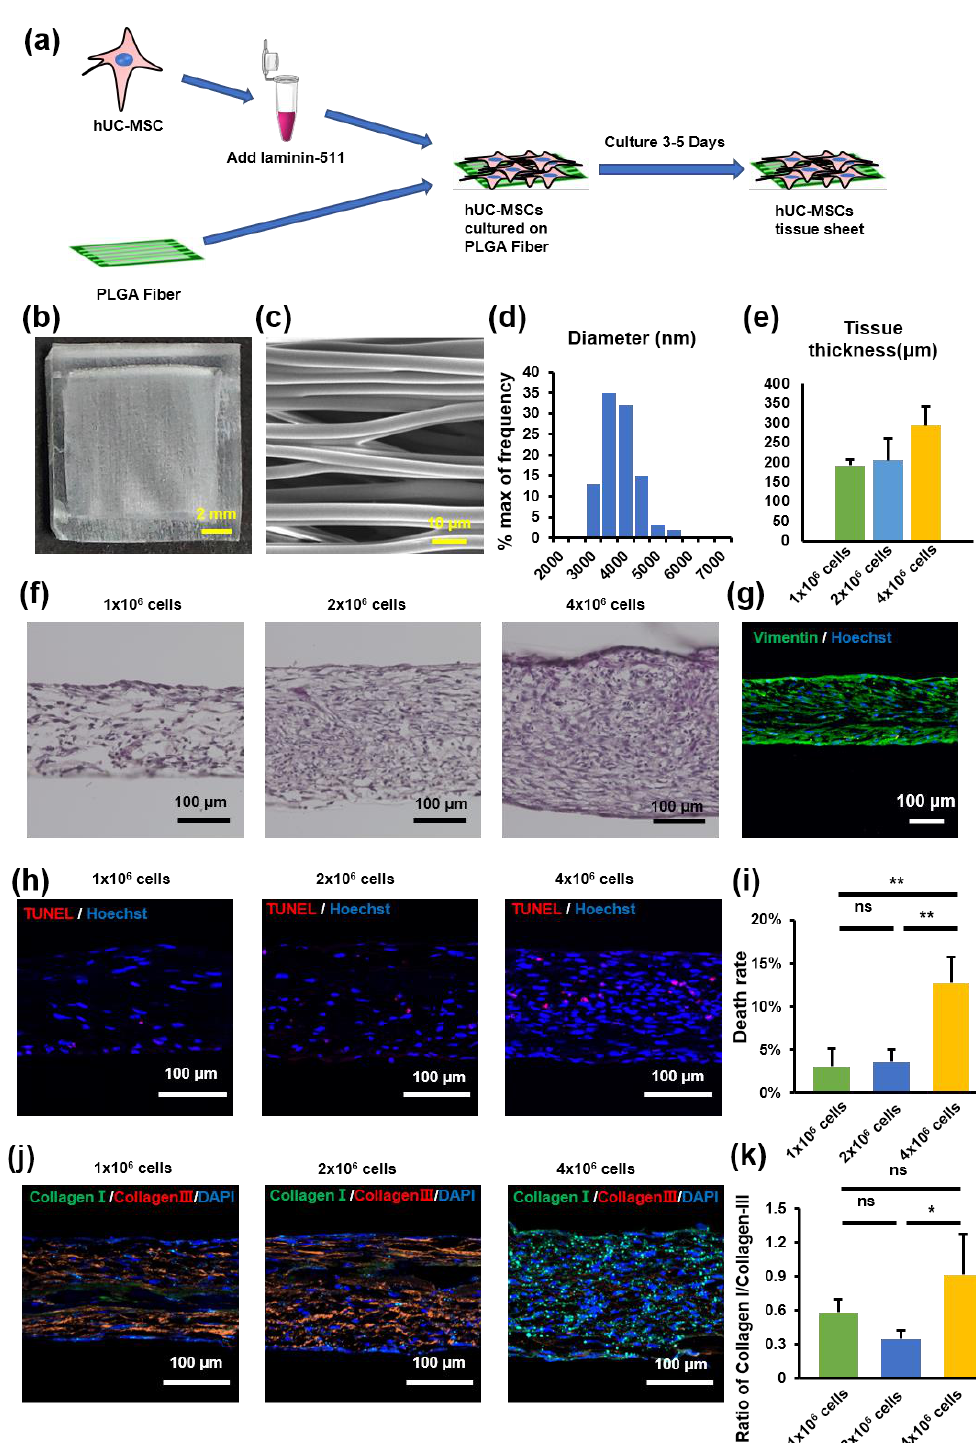
Figure 2. Human umbilical cord mesenchymal stem cell (hUC-MSC) tissue sheet construction and evaluation. ( a ) Schematic representation of tissue construction in vitro. ( b ) Image of PLGA-aligned fibers. Scale bar = 2 mm. ( c ) Scanning electron microscopy image of PLGA-aligned fibers. Scale bar = 10 μm. ( d ) Quantitative analysis of the diameter of fibers in PLGA-aligned fibers. ( e ) Quantitative analysis of the thickness of hUC-MSC tissue sheets with different cell densities in ( f ). ( f ) Hematoxylin and eosin staining of hUC-MSC tissue sheets with different cell densities. Scale bar = 100 μm. ( g ) Immunohistological images of Vimentin (green) in hUC-MSC tissue sheet (1 × 10 6 cells). Scale bar = 100 μm. ( h ) TUNEL staining of hUC-MSC tissue sheet sections with different cell densities. Scale bar = 100 μm. ( i ) Quantitative analysis of cell death rate in different groups. ( j )